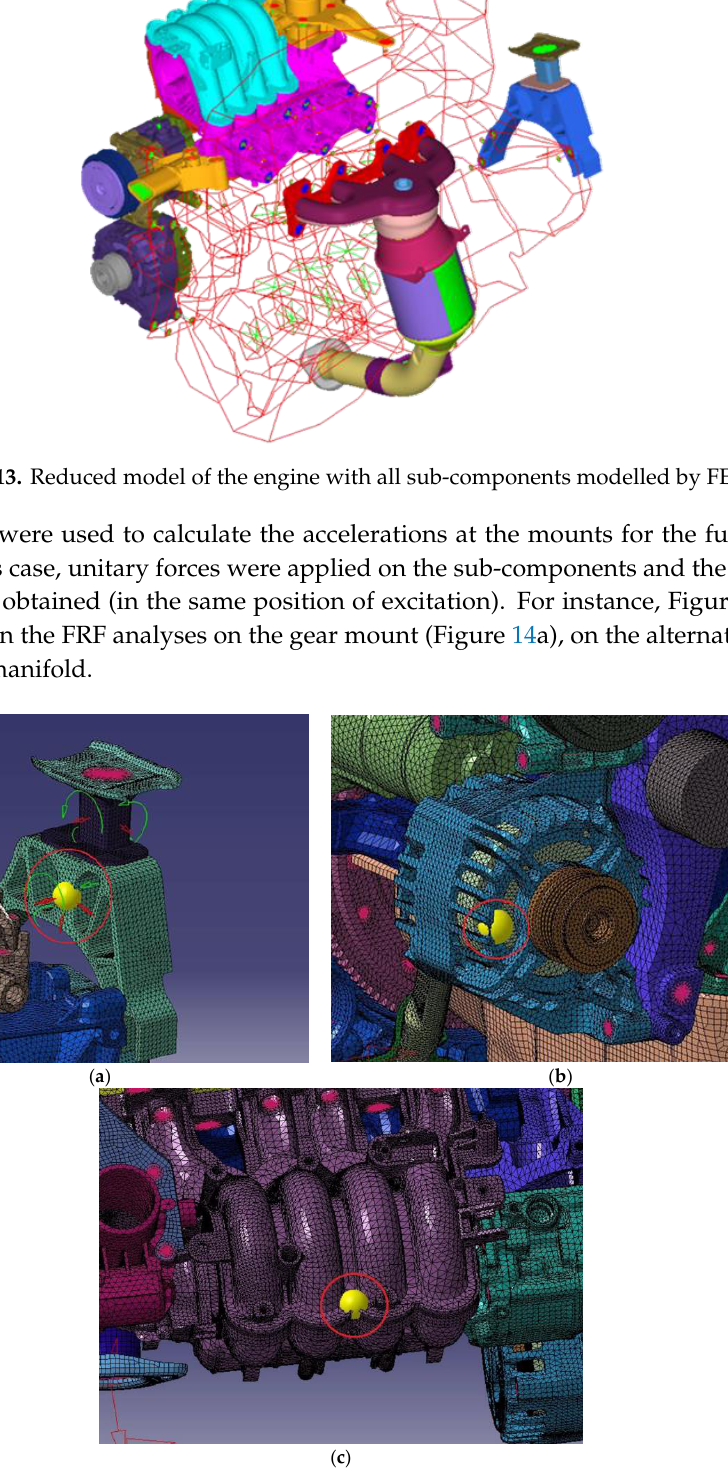
Figure 14. Relevant points (yellow dots) on the ( a ) gear mount; ( b ) alternator and ( c ) intake manifold considered in the FRF analyses.